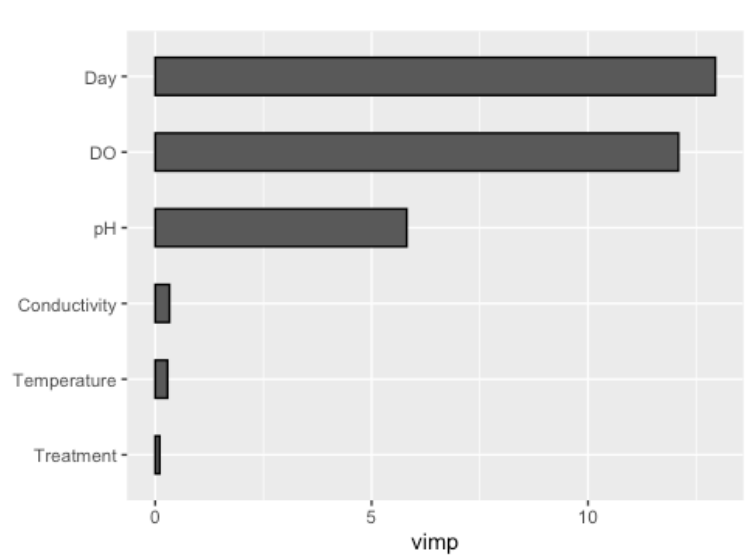
Figure A2. Variation in pH along time between treatments.